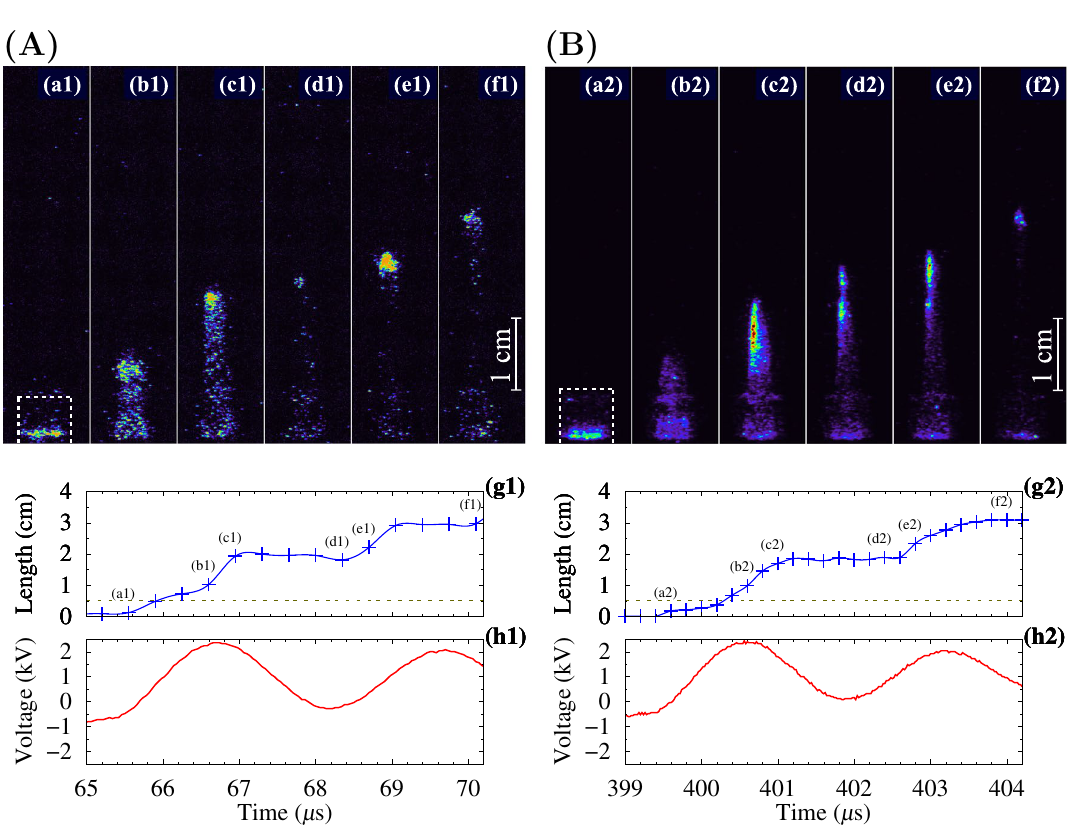
Figure 4. ( A ) High-speed ICCD images ( a1)–(f1 ), APPJ length ( g1 ) and voltage curve ( h1 ) for the 4th positive pulse in the bunch with the first positive pulse as in Fig. 3B. ( B ) The 16th positive pulse in the bunch with the first negative pulse, as shown in Fig. 1B(b). The exposure for frames was 50 ns with 5 accumulations in ( a1 )–( f1 ) and 50 ns with 15 accumulations in ( a2 )–( f2 ). The labels in the frames ( a )–( f ) corresponds to position of points indicated in graphs ( g1 ) and ( g2 ). The dashed contours in ( a ) are the tube’s